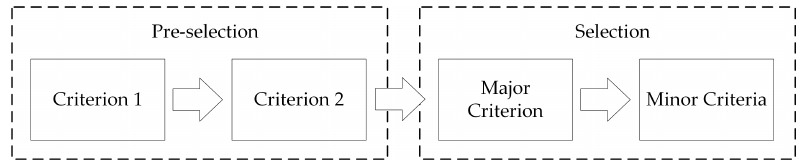
Figure 1. The general overview of sensor pre-selection and